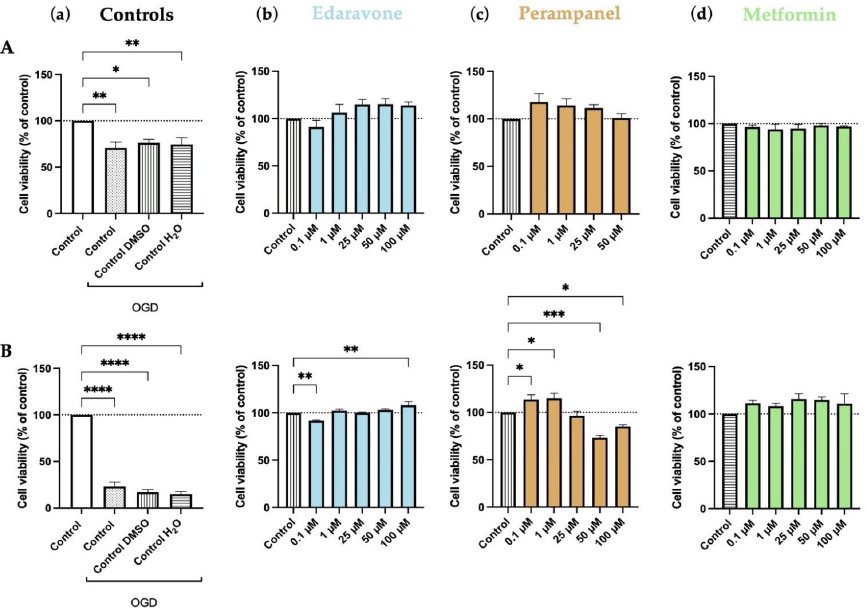
Figure 12. Effects of oxygen–glucose deprivation (OGD) and edaravone, perampanel, and metformin treatments for 6 ( A ) and 48 ( B ) hours on HT-22 cells viability. ( a ) Controls graph, comparing controls/vehicles in OGD conditions to standard medium. ( b ) Edaravone, ( c ) Perampanel, and ( d ) Metformin treatments, while in OGD conditions. Cell viability was assessed by MTT assay. Results are expressed as the percentage of cell viability relative to untreated control cells submitted to OGD. *, **, *** and **** indicate p < 0.05, p < 0.01, and p < 0.001, respectively, when compared to the respective control. All data are presented as the mean + SEM of three independent experiments.